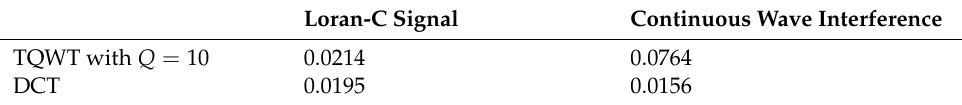
Figure 5. The simulation signal. ( a ) Simulated Loran-C signal. ( b ) Simulated continuous wave interference. ( c ) Gaussian white noise. ( d ) Composite signal. Table 1. The sparsity estimation using the TQWT with Q = 10 and the